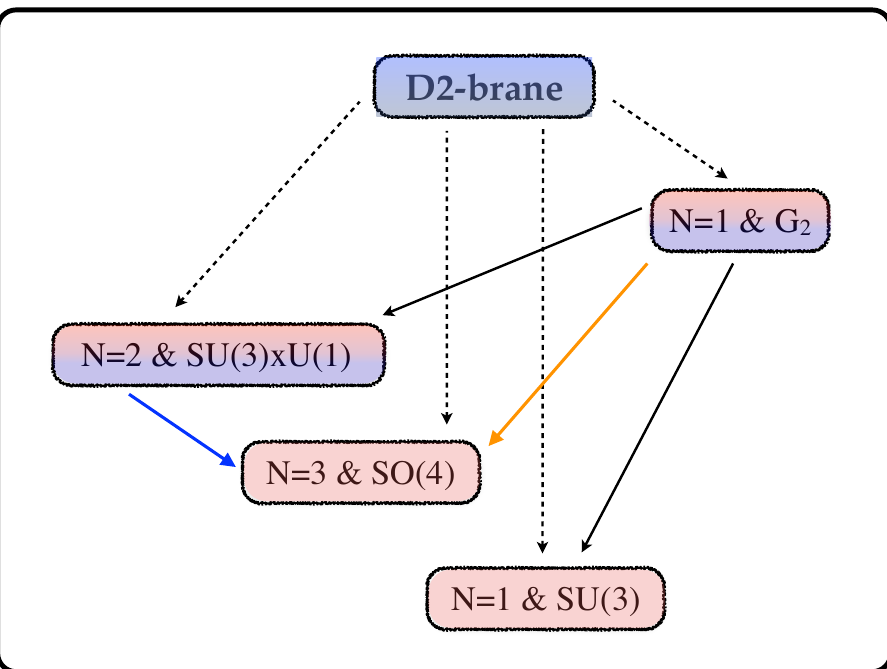
Figure 1: RG flows from SYM (dotted lines) and between CFT’s (solid lines) dual to BPS Figure 1 . Network of domain-walls connecting the D2-brane behaviour (SYM-CS) and the pre- viously known supersymmetric AdS 4 solutions (CFTs) of the ISO(7) maximal supergravity. The domain-wall solutions within the SU(3) and SO(4) invariant sectors of the dyonic ISO(7)- black lines (solid and dashed) correspond to domain-walls previously constructed in the SU(3) gauged maximal supergravity.